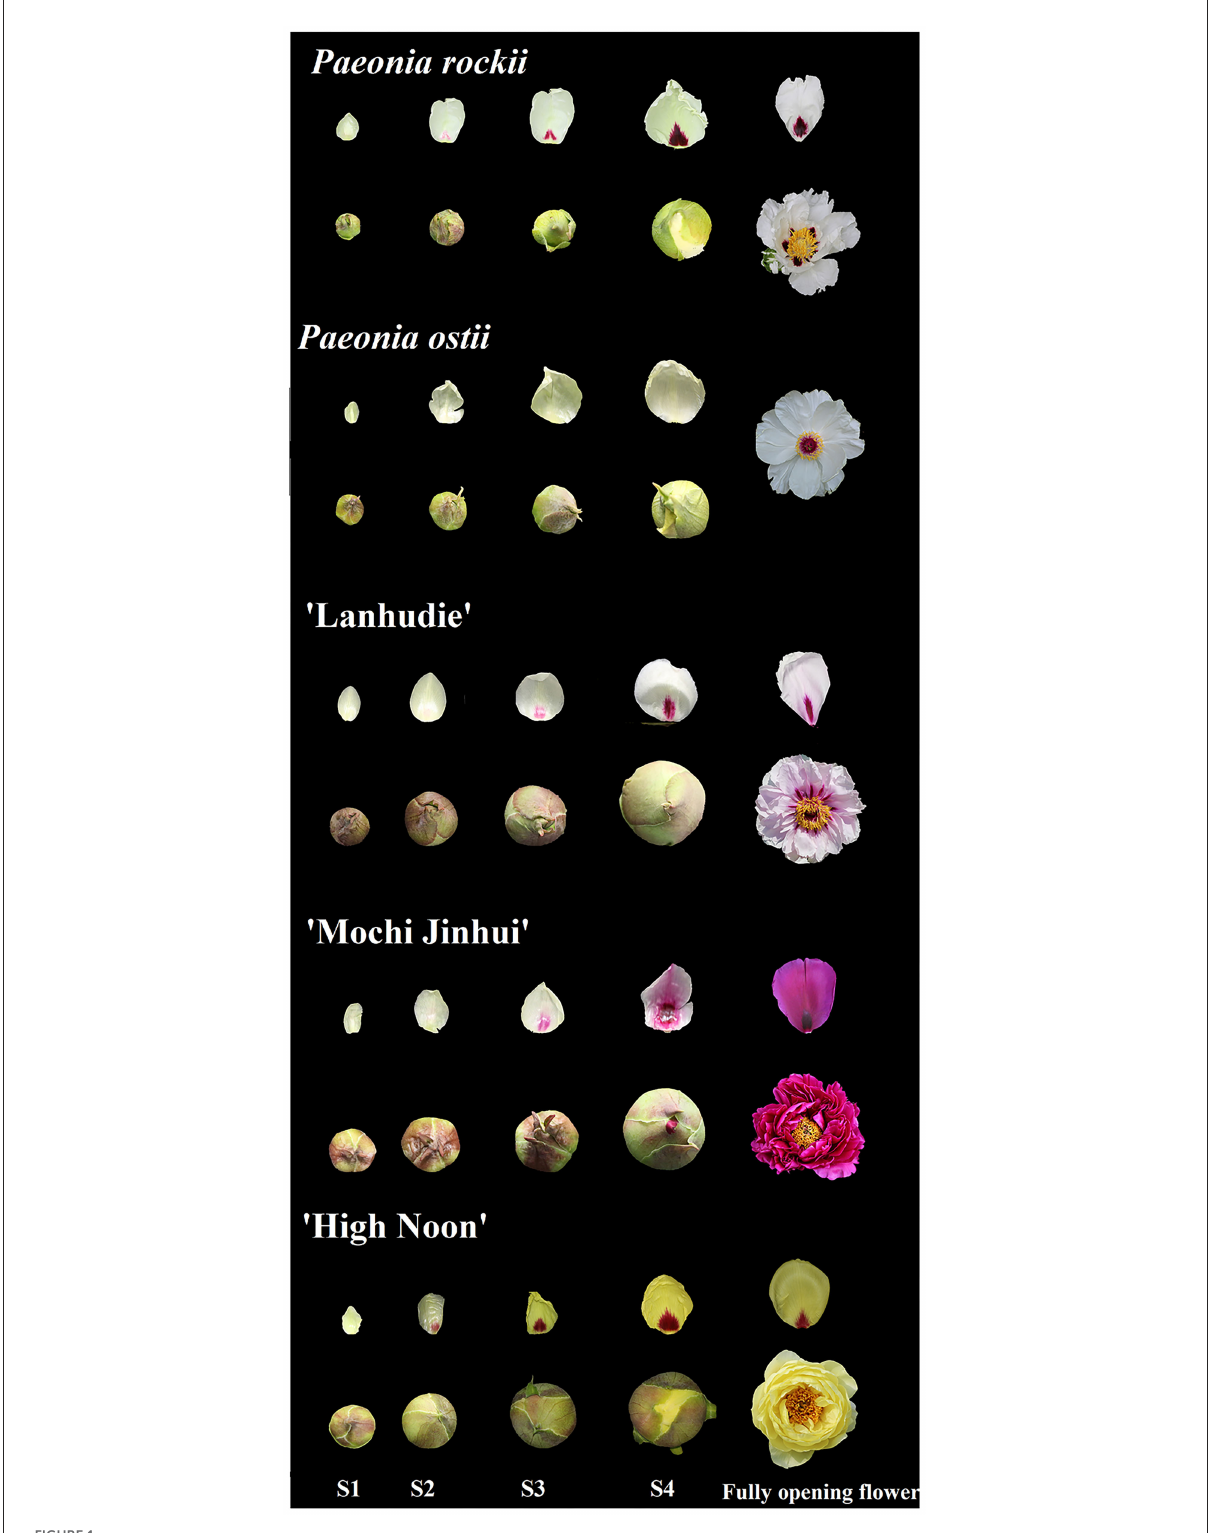
FIGURE1 Flower phenotypes of Paeonia rockii, P. ostii, P. suffruticosa “Lanhudie,” “Mochi Jinhui,” and “High Noon” at four different opening stages. S1: stage 1, small bell-like bud stage when the petals were mainly yellow-green; S2: stage 2, large bell-like bud stage when the petal bases turn obvious color with the yellow-green background; S3: stage 3, bell-like bud extending stage when spots get bigger and darker; S4: stage 4, initiating blooming stage when spots are completely